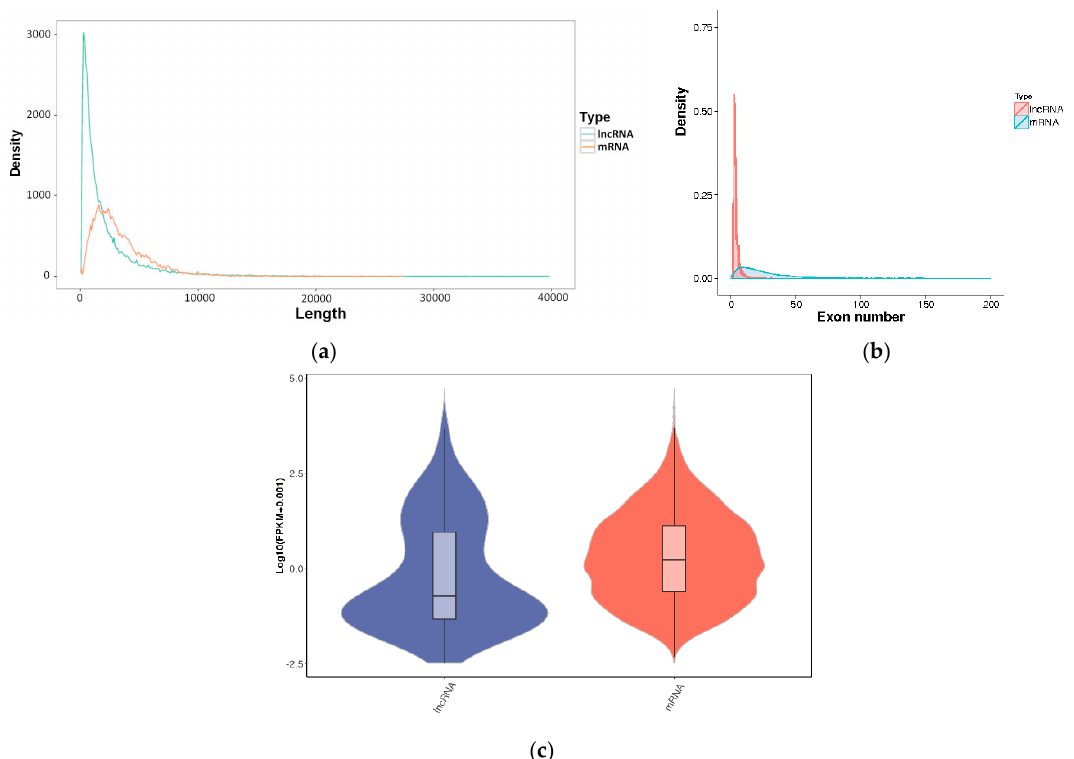
Figure 2. The characteristics of lncRNAs and mRNAs. ( a ) Length distribution; ( b ) Exon number distribution; ( c ) FPKM.